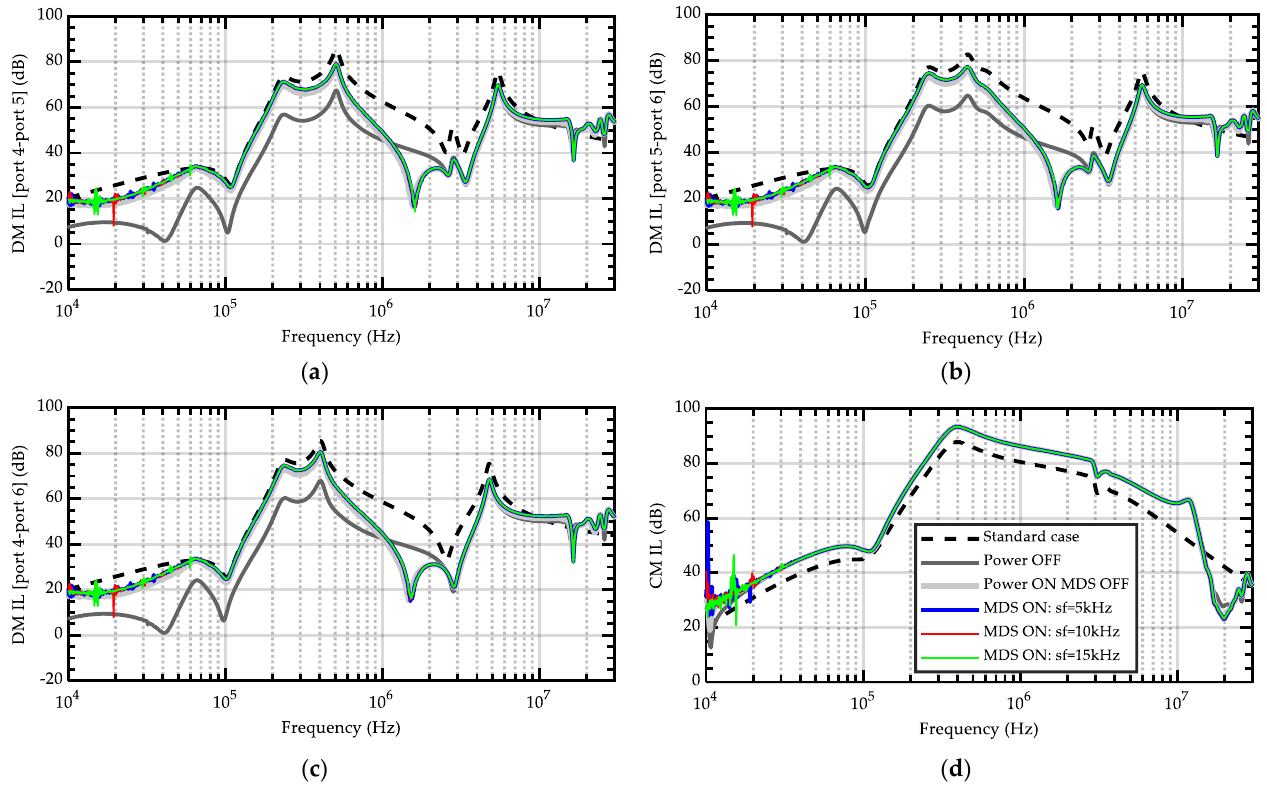
Figure 13. Two-stage filter: DM IL between ( a ) port 4 – 5, ( b ) port 5 – 6 and ( c ) port 4 – 6, and ( d ) CM IL.